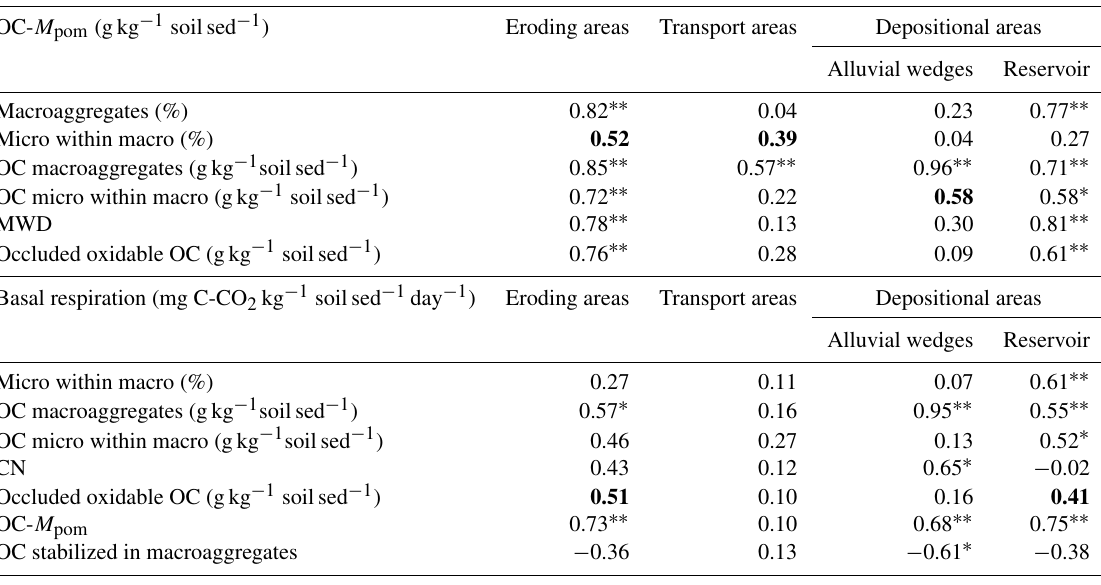
Table 5. Spearman correlation coefficients between the OC associated with intra-aggregate POM (OC- M pom ) or basal respiration (BR) and aggregate percentage and associated total OC, MWD, occluded oxidable OC, CN ratios, and OC stabilized in macroaggregates in the different geomorphological positions within the catchment: eroding, transport, and depositional